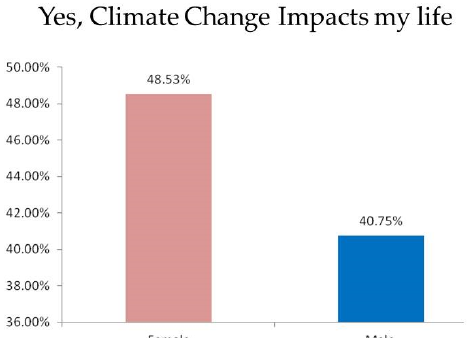
Figure 2. Gender (female/male) of the respondents who affirmed, “Yes, climate change impacts my life”.